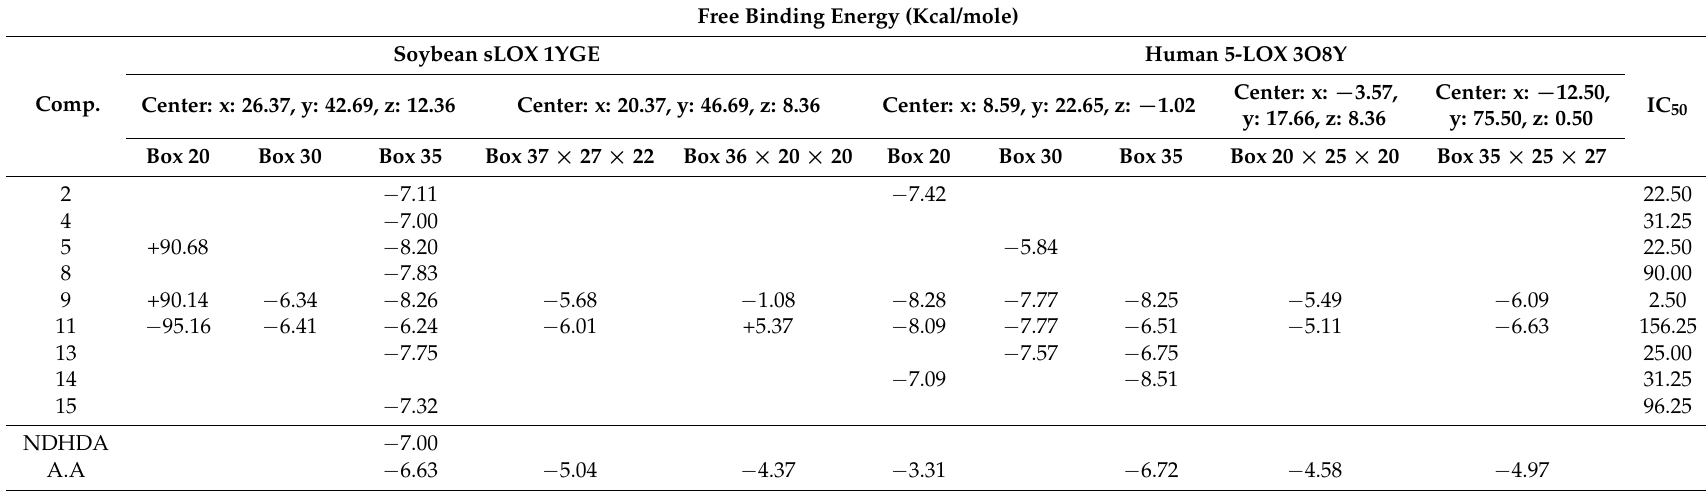
Table 6. Results of docking analysis to the sLOX structure 1YGE and to human 5-LOX structure 3O8Y using different target center and box dimensions. Free Binding Energy